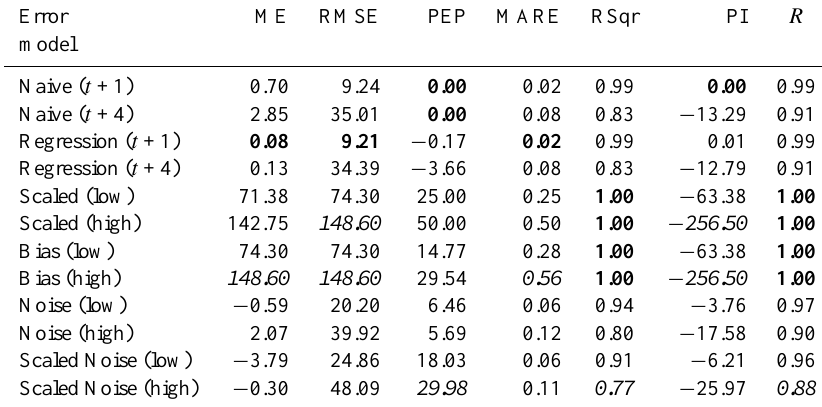
Table 2. Individual statistics for experimental data series (“best” result in bold, “worst” result in italic per metric). Error ME RMSE PEP MARE RSqr PI R model Naive ( t +1)